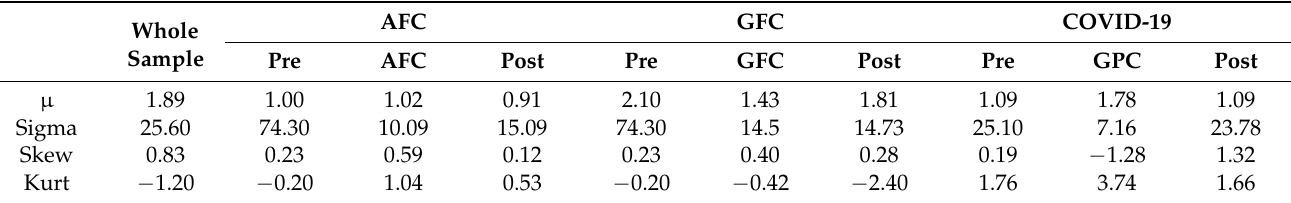
Table 2. Time-varying Informational Efficiency of PSX-100